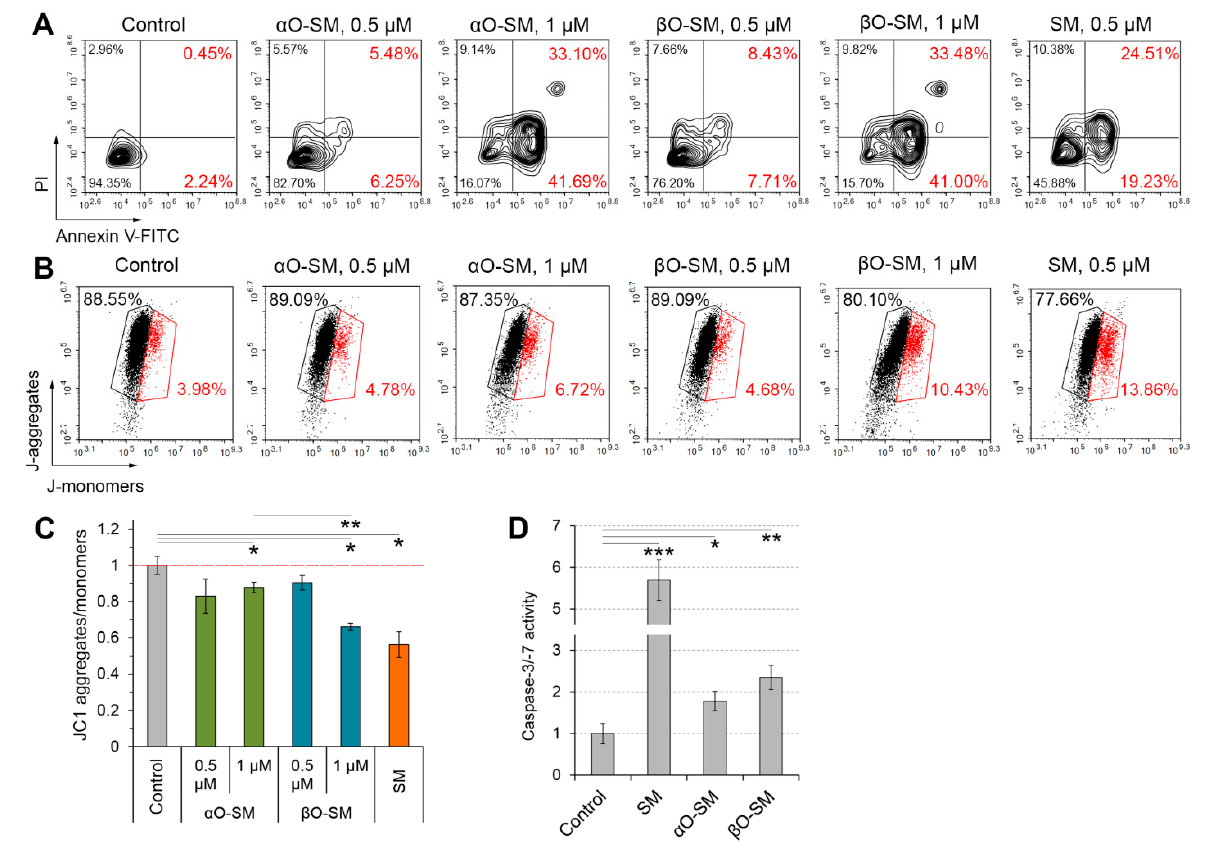
Figure 1. Evaluation of the pro-apoptotic activity of α O-SM and β O-SM in B16 melanoma cells. ( A ) Dose-dependent effect of SM epoxides on the apoptosis induction in B16 melanoma cells. Flow cytometry analysis, double staining using Annexin V-FITC/PI. ( B ) Dose-dependent effect of SM epoxides on mitochondrial membrane potential in B16 cells. Flow cytometry analysis, staining with JC-1. ( C ) The ratio of JC-1 aggregates to monomers for the control and triterpenoid incubated cells. The data are expressed as mean ± SD of three independent experiments. ( D ) Activation of caspase-3/-7 in B16 cells incubated with SM , α O-SM or β O-SM at 1 µM for 24 h. The data are expressed as mean ± SD of three independent experiments. * p < 0.05; ** p < 0.01; *** p < 0.001.